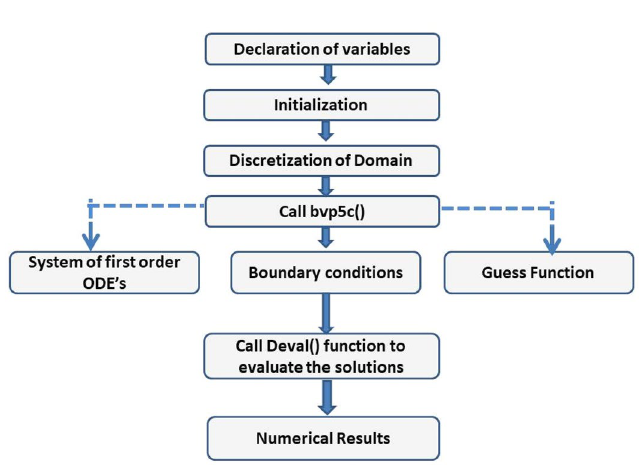
Chart 1. Algorithm of bvp5c method to solve boundary value